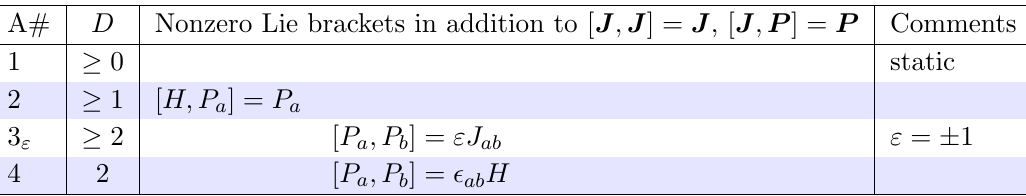
Table 17 . Aristotelian Lie